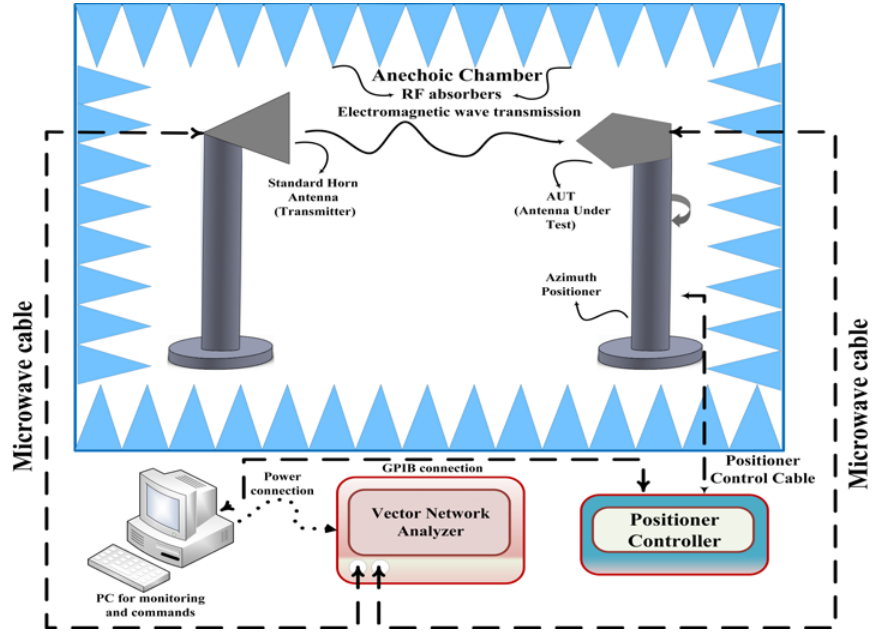
Figure 12. Visualization of the entire measurement setup.